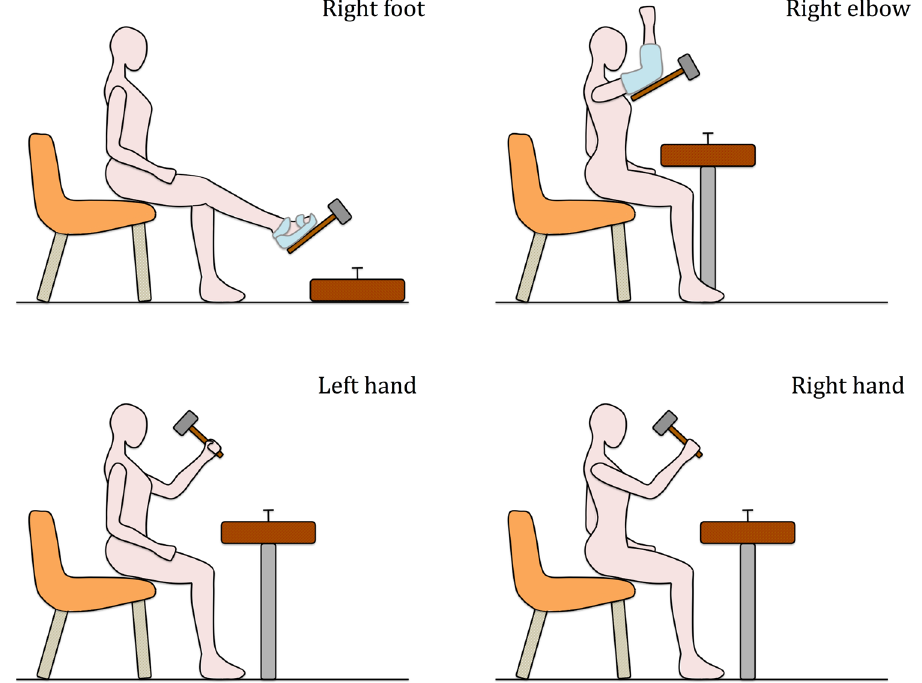
Figure 1. Experimental setup. Ten right-handed participants were asked to perform three real tool-use actions (i.e., pounding a nail with a hammer, sweeping sawdust with a brush, painting with a roller) by using four different end-effectors in the following order: Right foot (customized snowboard fixation), right elbow (customized moldable plastic cast), left hand, and right hand. Here, only the hammer condition is